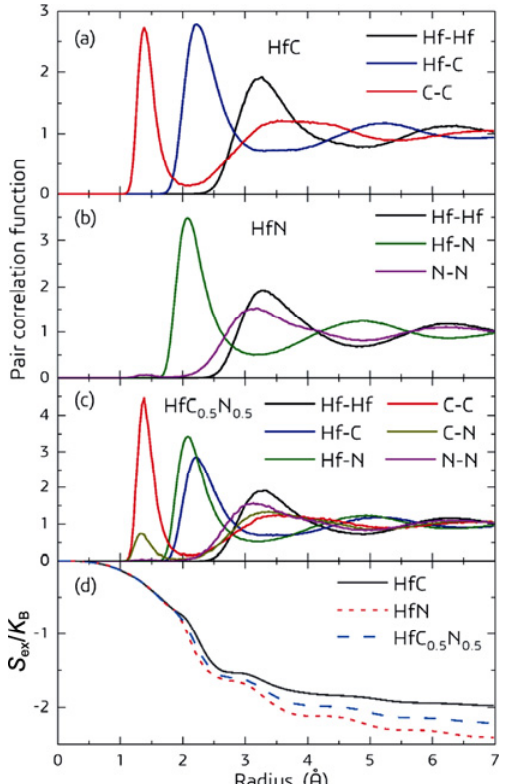
Fig. 7 Pair correlation function (normalized as r → + ∞ ) in liquid-state (a) HfC, (b) HfN, and (c) HfC 0.5 N 0.5 . (d) Comparison of / S k of liquid-state HfC, HfN, ex B and HfC 0.5 N 0.5